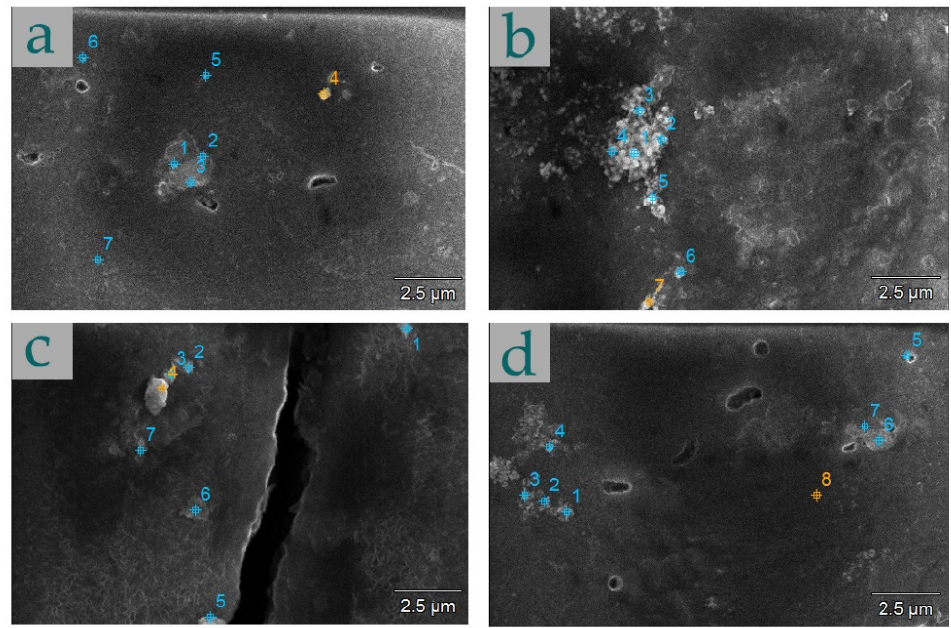
Figure 6. Microphotographs of samples of groups ( a ) AE-0.5, ( b ) AE-8, ( c ) BE-0.5, and ( d )